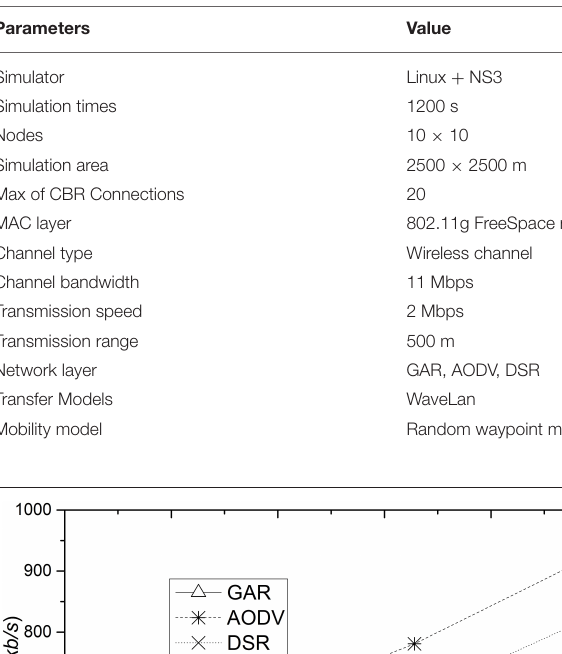
TABLE 2 | Simulation parameters.